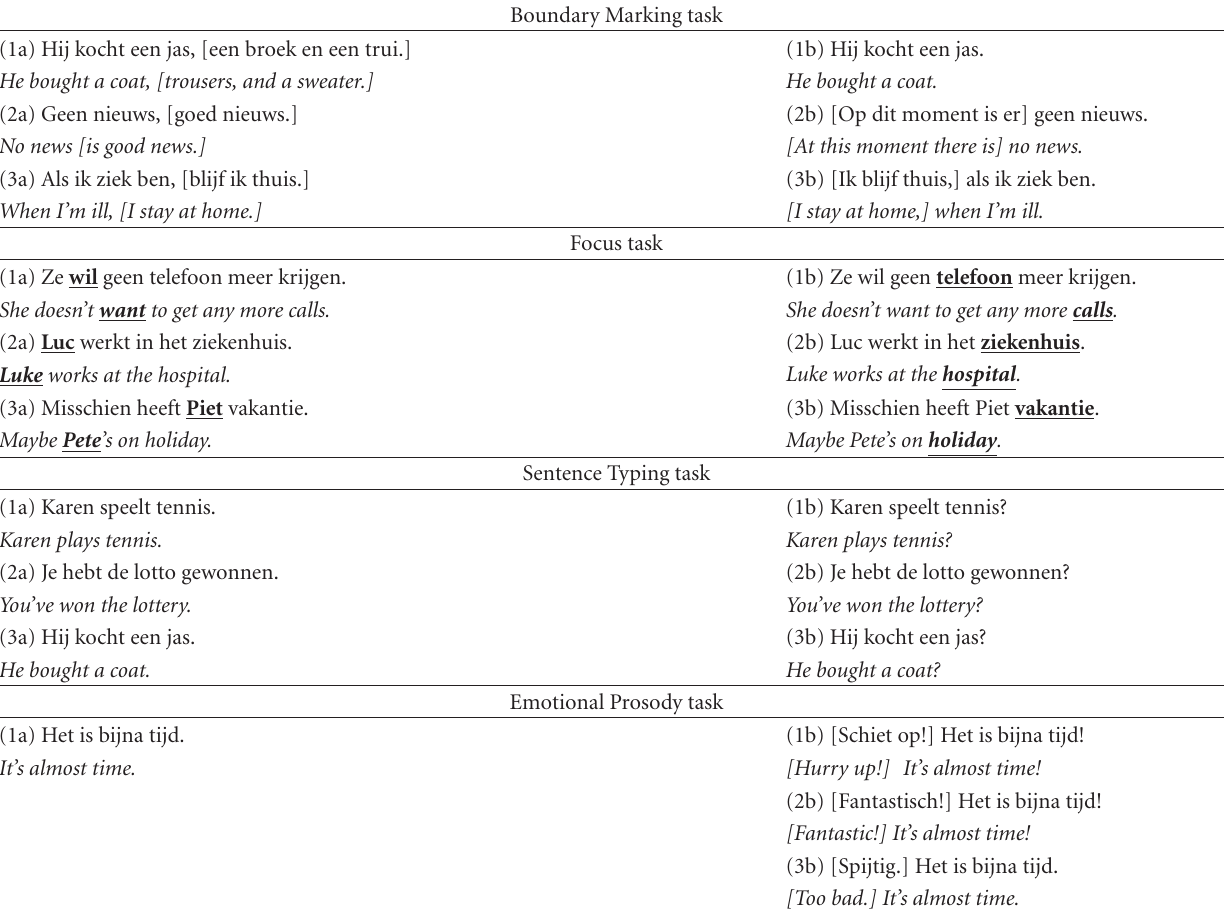
Table 2: Overview of the reading and imitation tasks; all task items included (English translations in